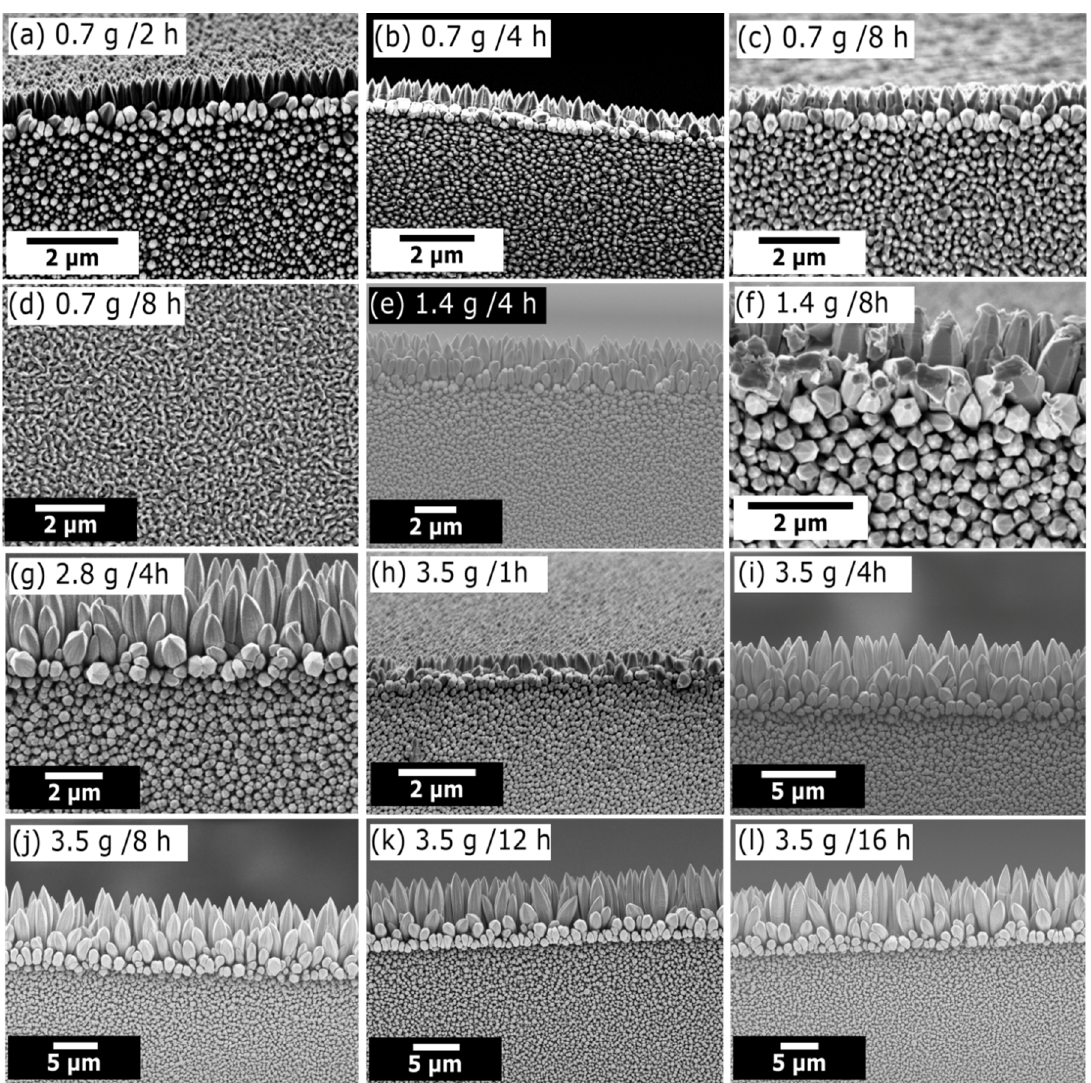
Figure 5. Scanning electron micrographs of the nanowhiskers’ morphology as a function of the amount of zinc precursor and the growth time. By using 0.7 g zinc precursor powder, the nanowhiskers grow for ( a ) 2 h, ( b ) 4 h, and ( c , d ) 8 h. The results of nanowhisker growth for a zinc precursor amount of 1.4 g at growth times for 4 h and 8 h are shown in ( e ) and ( f ), respectively. By using 2.8 g zinc precursor and 4 h growth time, the nanowhiskers in ( g ) are formed. A zinc precursor amount of 3.5 g is used for the samples ( h )–( l ), while the growth time is varied between ( h ) 1 h, ( i ) 4 h, ( j ) 8 h, ( k ) 12 h, and ( l ) 16 h, respectively.